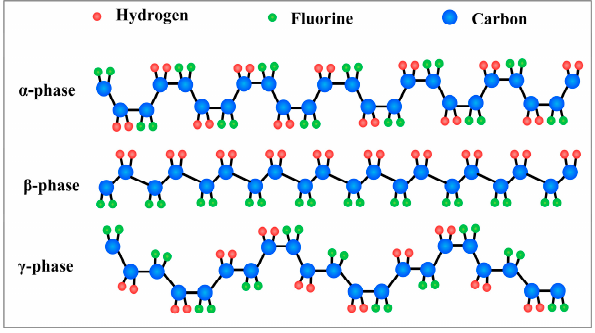
Figure 2. Schematic representation of the chain conformation for the α , β and γ -phases of polyvinylidene fluoride (PVDF).